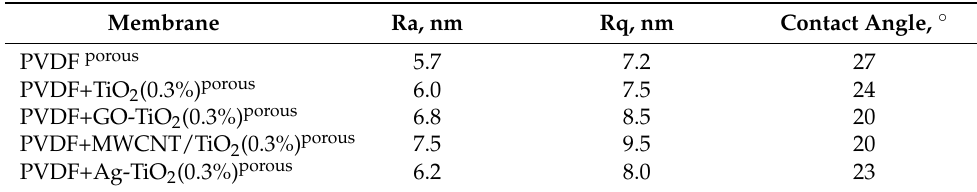
Table 2. Average (Ra) and root-mean-squared (Rq) roughness values and contact angles for porous PVDF and PVDF/nanoparticle membranes.